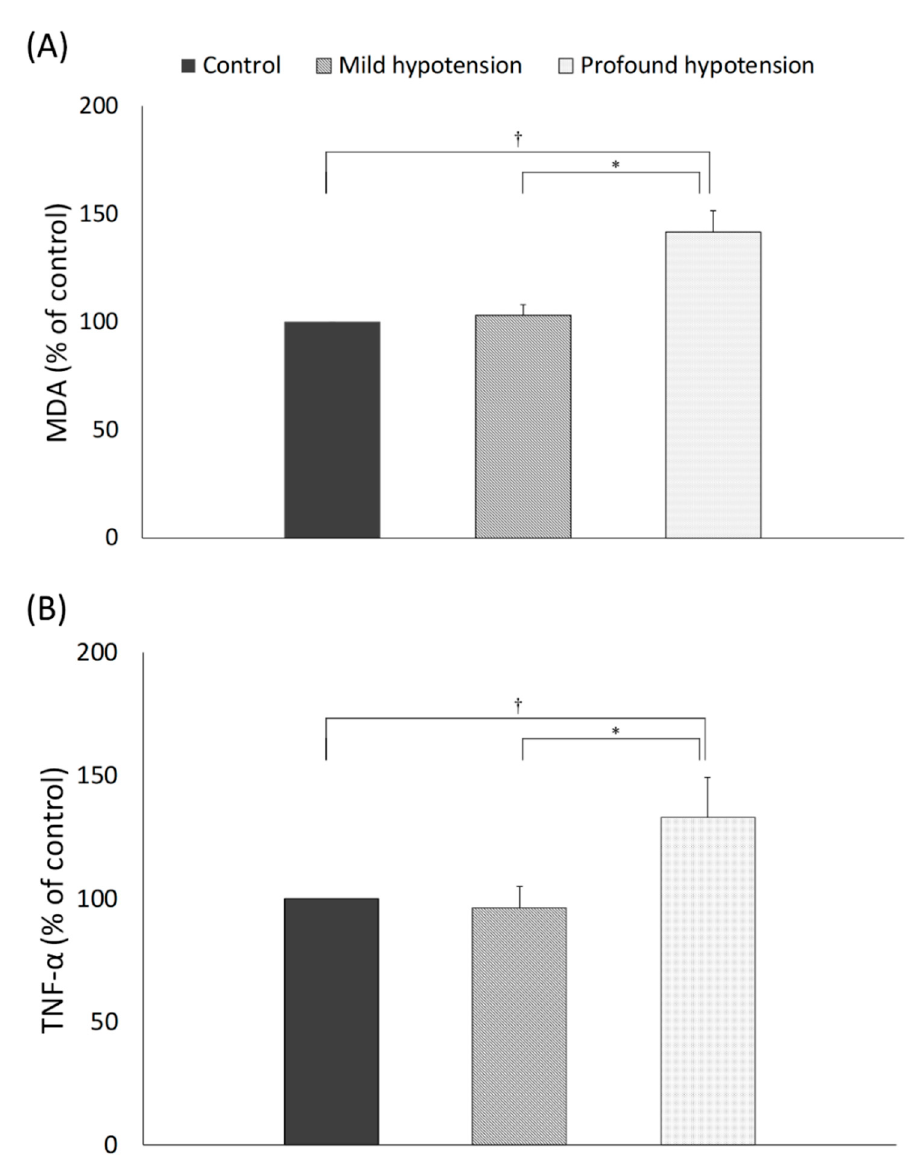
Figure 3. The level of spinal cord tissue MDA (malondialdehyde) ( A ) and TNF- α (tumor necrosis factor- α ) ( B ). The levels of MDA and TNF- α were different among the groups ( p < 0.001). The profound hypotension group showed significantly increased level of MDA and TNF- α compared to other groups. p < 0.001 (*, † ) by unpaired t-test.